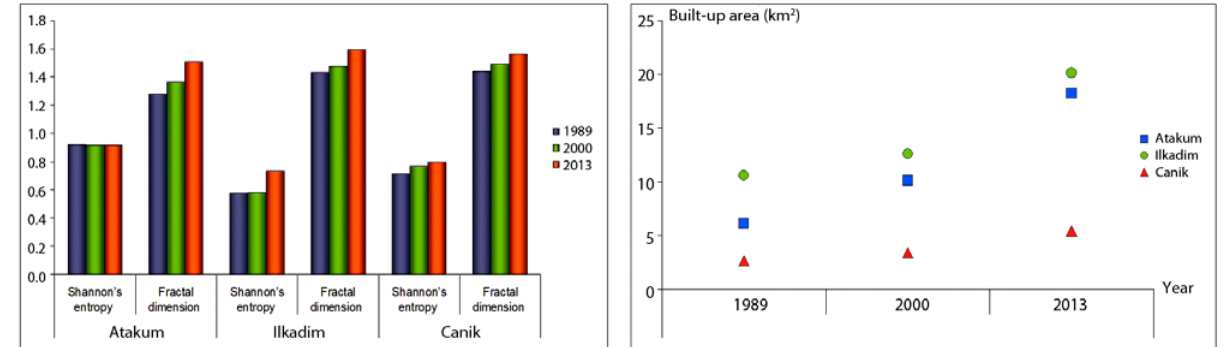
Table 5. Population and annual population growth rates in Atakum, Ilkadim and Canik District 2008 2014 Atakum 107 953 158 031 Ilkadim 298 850 308 170 Canik 65 724 79